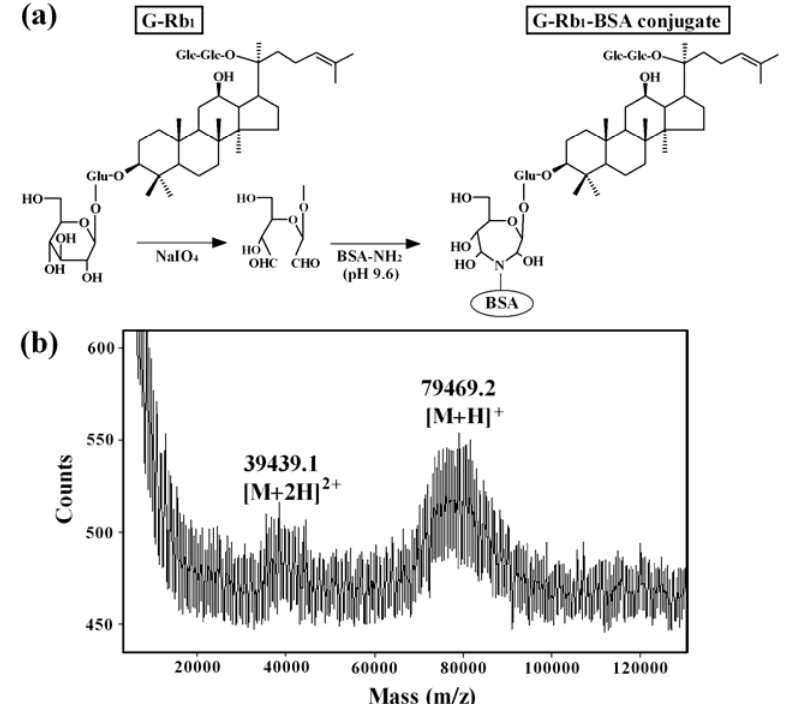
Figure 1. ( a ) Synthesis of G-Rb conjugate by MALDI-TOF mass